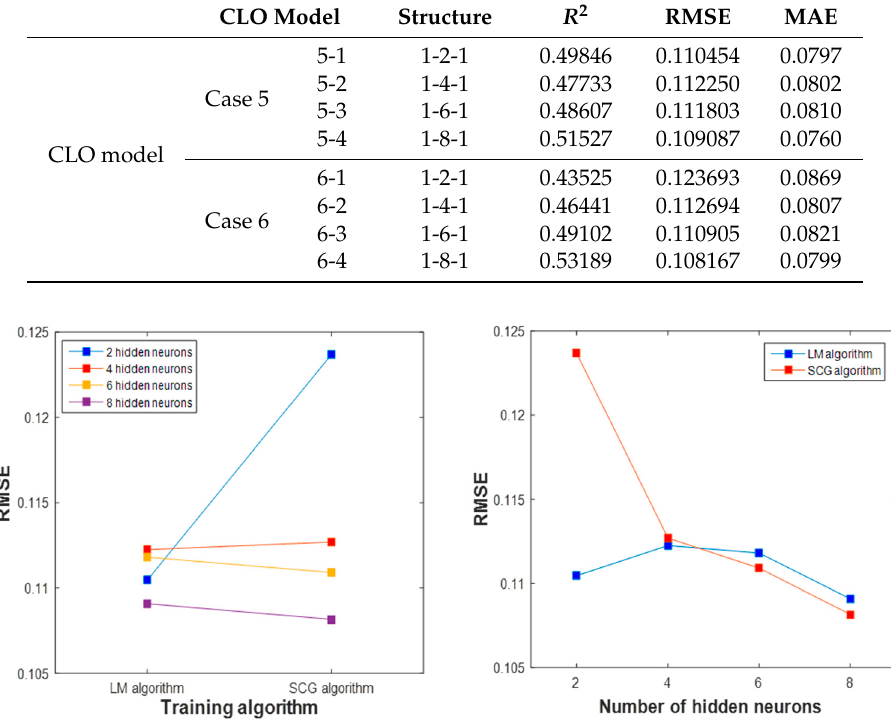
Figure 7. Results of RMSE for T and MRT prediction models according to the floors and number of datasets. Table 7. Accuracy of CLO prediction models according to the model structures.